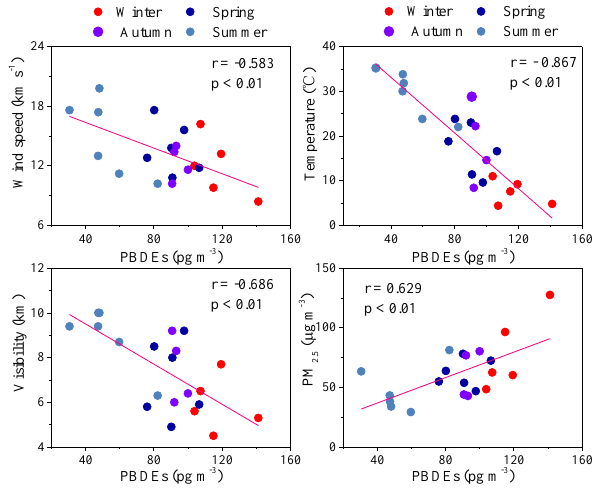
Figure 2. Pearson correlation between particulate PBDEs and weather parameters: visibility, temperature, wind speed and PM 2 . 5 .